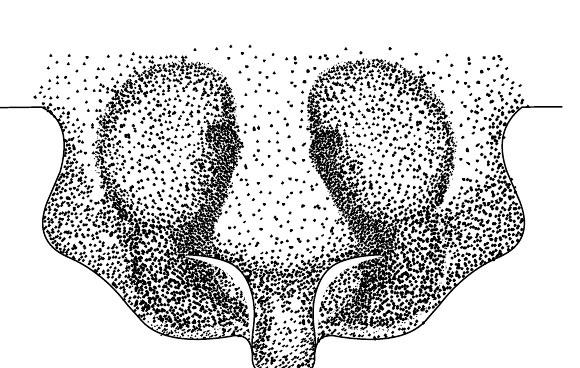
Figure 2. Epigyne dorsal